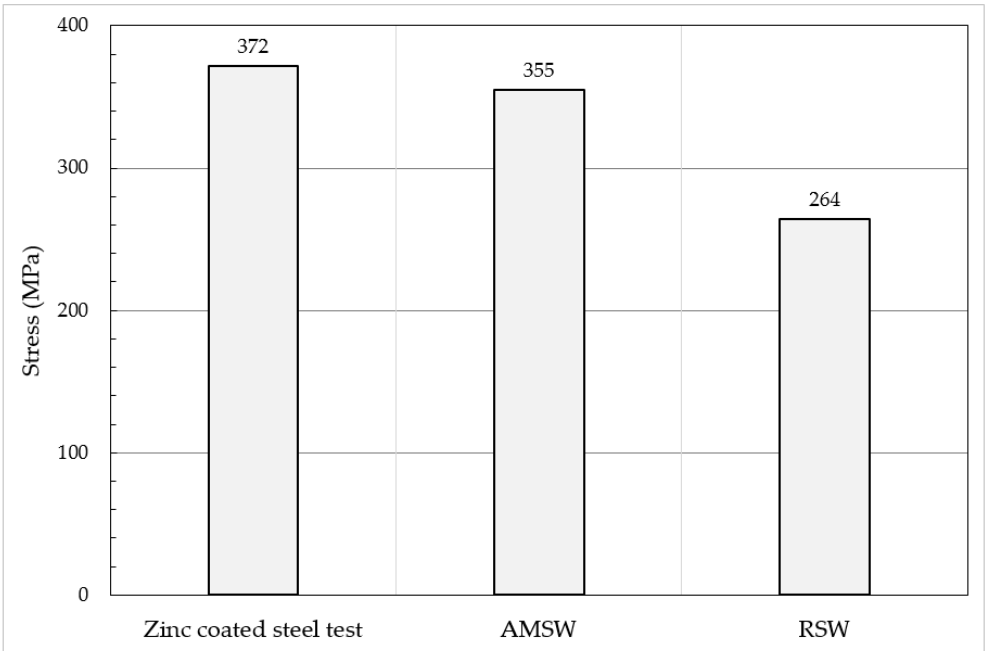
Figure 10. Comparison of maximum tensile shear stress between the weld spots by the spot welding process using additive manufacturing (AMSW) and the resistance spot welding process (RSW), in relation to the maximum tensile stress of the zinc coated sheet.